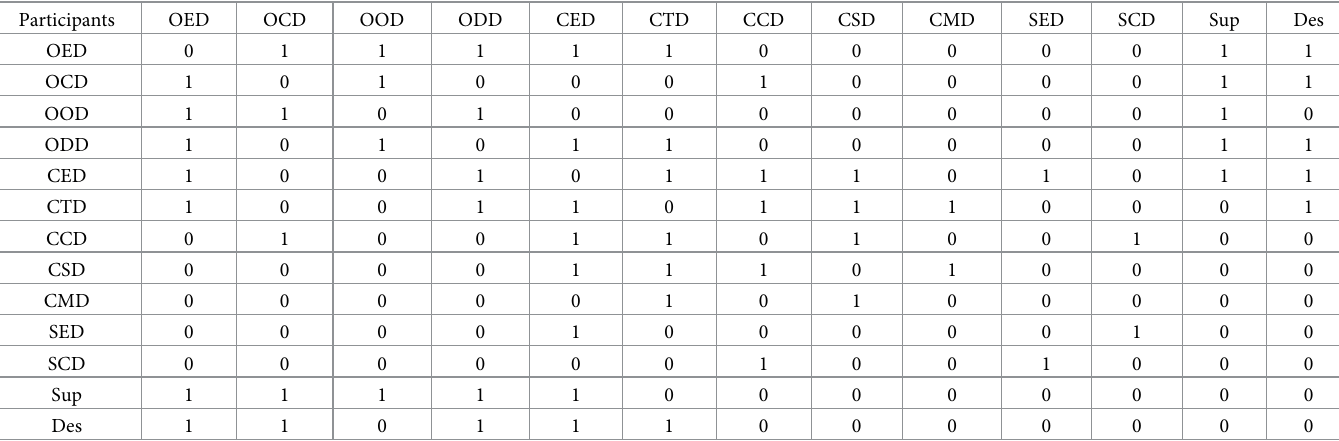
Table 1. 0–1 matrix of communication relationships before BIM use.